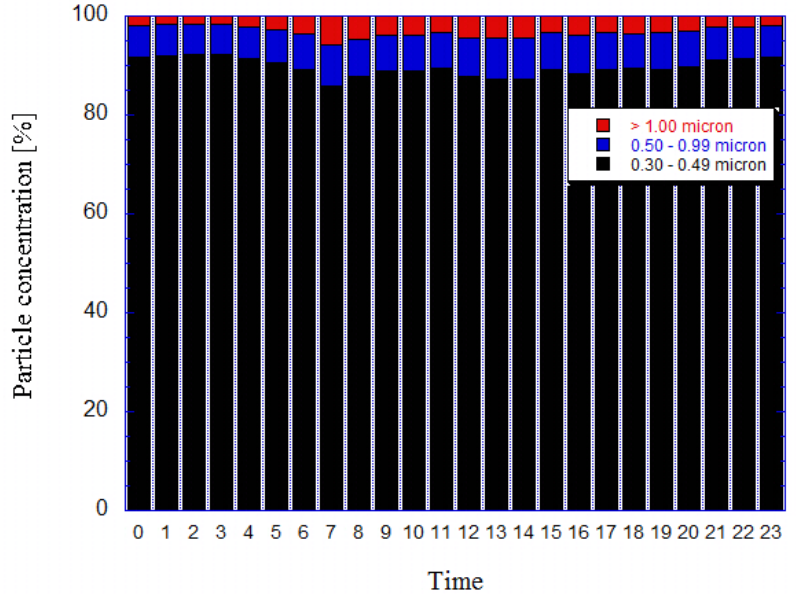
Figure 10. Hourly trend of the PM percentage number concentration monitored in the bus terminal (level − 1 ) of Collemaggio parking site, L’Aquila, in the period June 2016–August 2016. Three granulometric sizes are shown: 0.30–0.49 µm, 0.50–0.99 µm and >1.00 µm. Analysis of hourly averages. Data collected by OPC TSI .